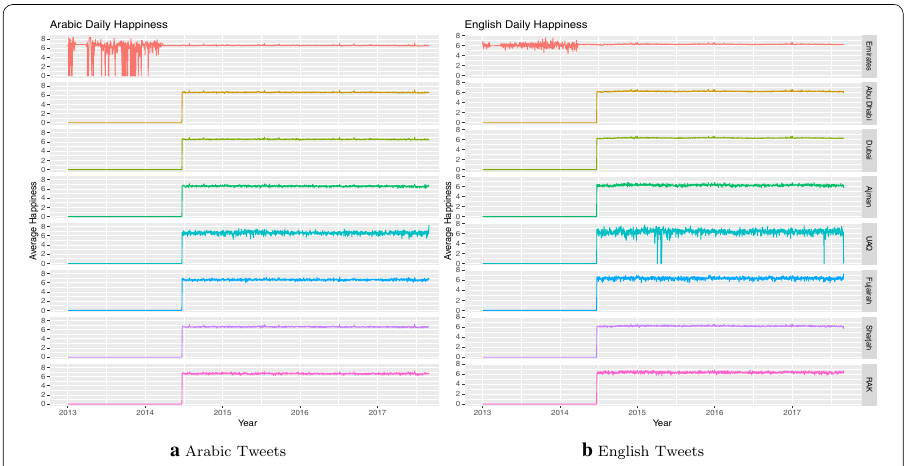
Fig. 3 Average daily happiness throughout the